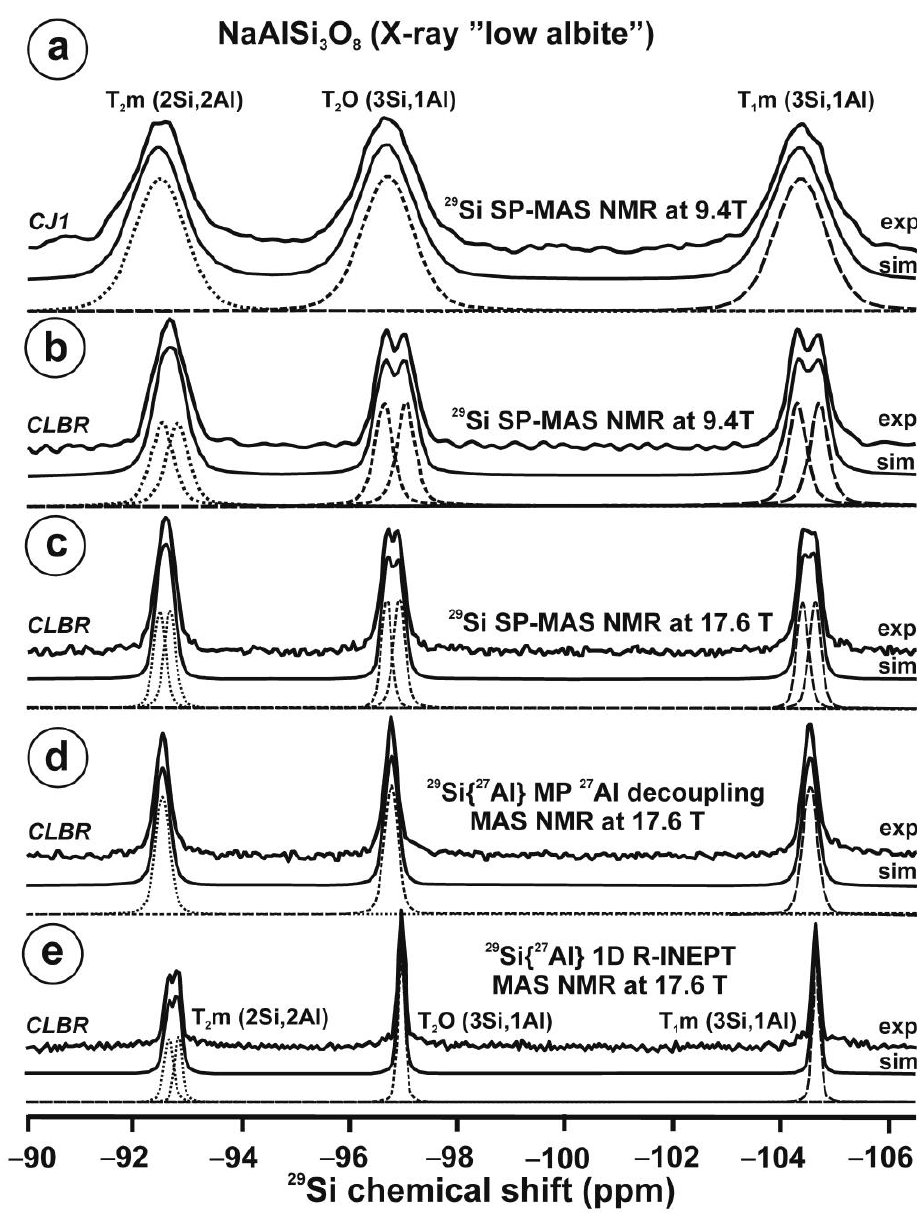
Figure 24. The 29 Si MAS NMR spectra of Na-feldspar in the “X-ray albite” variant. ( a ) Single pulse spectrum in specimen CJ1 at 9.4 T, 4.0 mm rotor, using a recycle delay of 45 s, pulse 0.5 μs and ν r = 14.3 kHz. ( b ) Single pulse spectrum in specimen CLBR at 9.4 T, 4.0 mm rotor, using a recycle delay of 90 s, pulse 0.5 μs and ν r = 14.3 kHz. ( c ) 29 Si SP-MAS NMR at 17.6 T in specimen CLBR, 4.0 mm rotor, using a recycle delay of 180 s, pulse 1.4 μs, and ν r = 10 kHz. ( d ) 29 Si{ 27 Al} MP decoupling in specimen CLBR at 17.6 T, 4.0 mm rotor, using a recycle delay of 180 s, {90}30 μs, pulse 1.4 μs and ν r = 10 kHz. ( e ) 29 Si{ 27 Al} 1D R- INEPT spectrum at 17.6 T, ν r = 14 kHz, 4.0 mm rotor, recycle delay of 20 s, pulses {12.1}12.5 μs, ν rf = {2.77}2.60 kHz. See text and Table 12 for explanations.